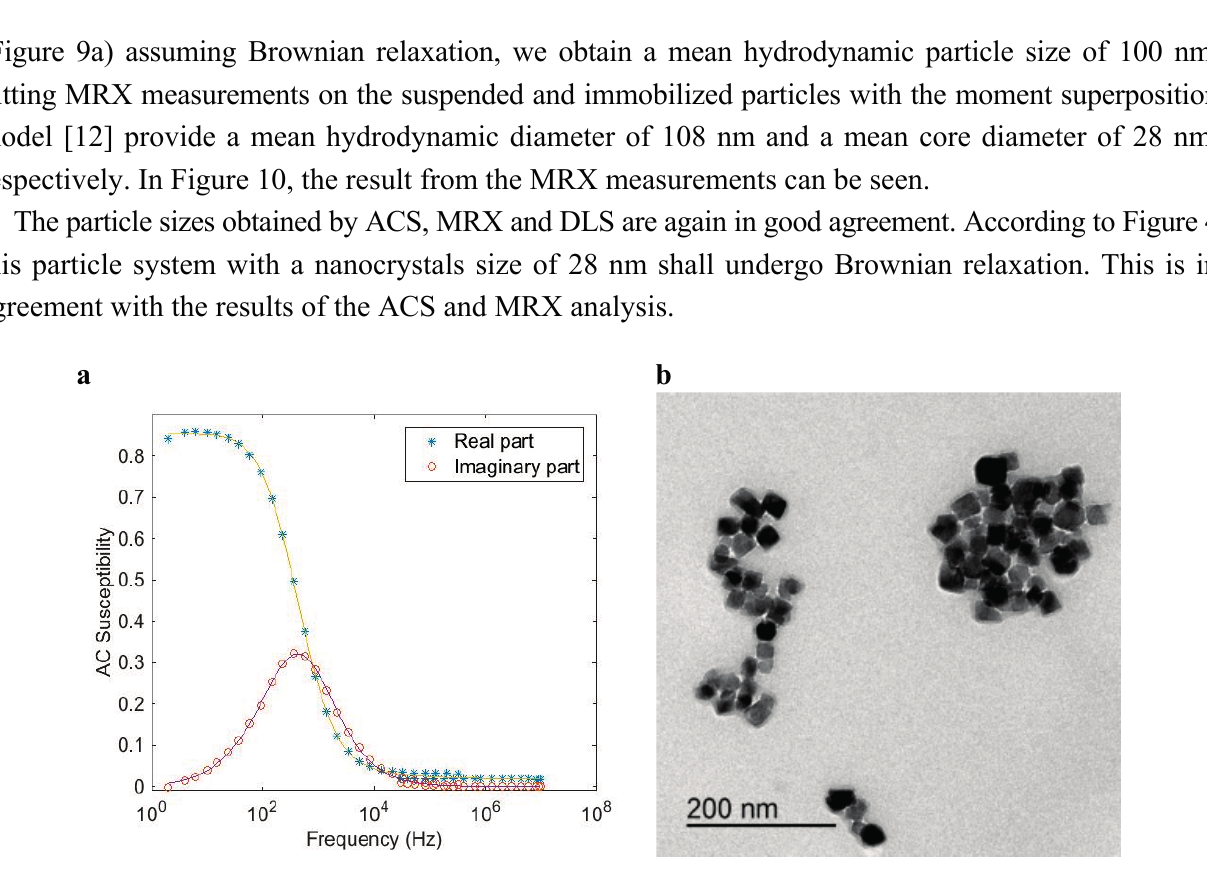
Figure 9. ( a ) AC susceptibility vs. frequency at room temperature of a magnetic multi-core particle system ( CSIC05 ) that shows Brownian relaxation with a relaxation frequency at about 300 Hz. The solid line in the figure is from the fitting procedure to the multi-core model; ( b ) TEM image of the particle system.